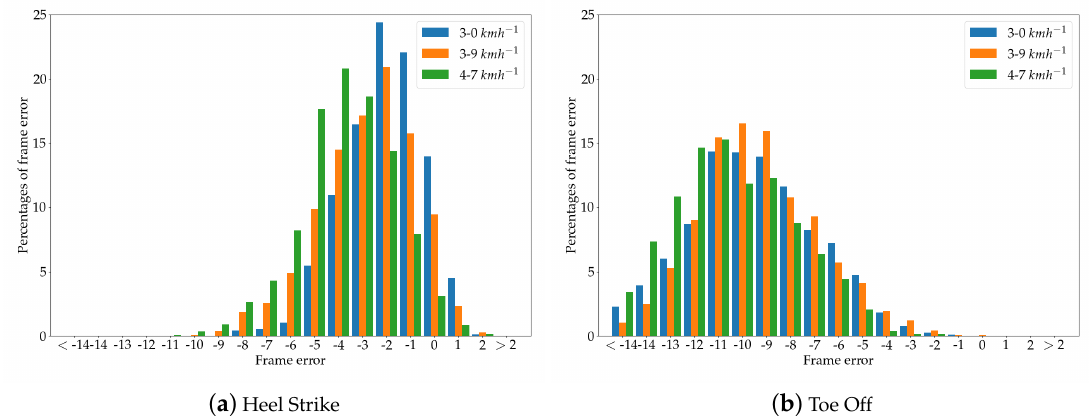
Figure 7. Gait event timing of Kinect v2 with respect to the Vicon reference system.